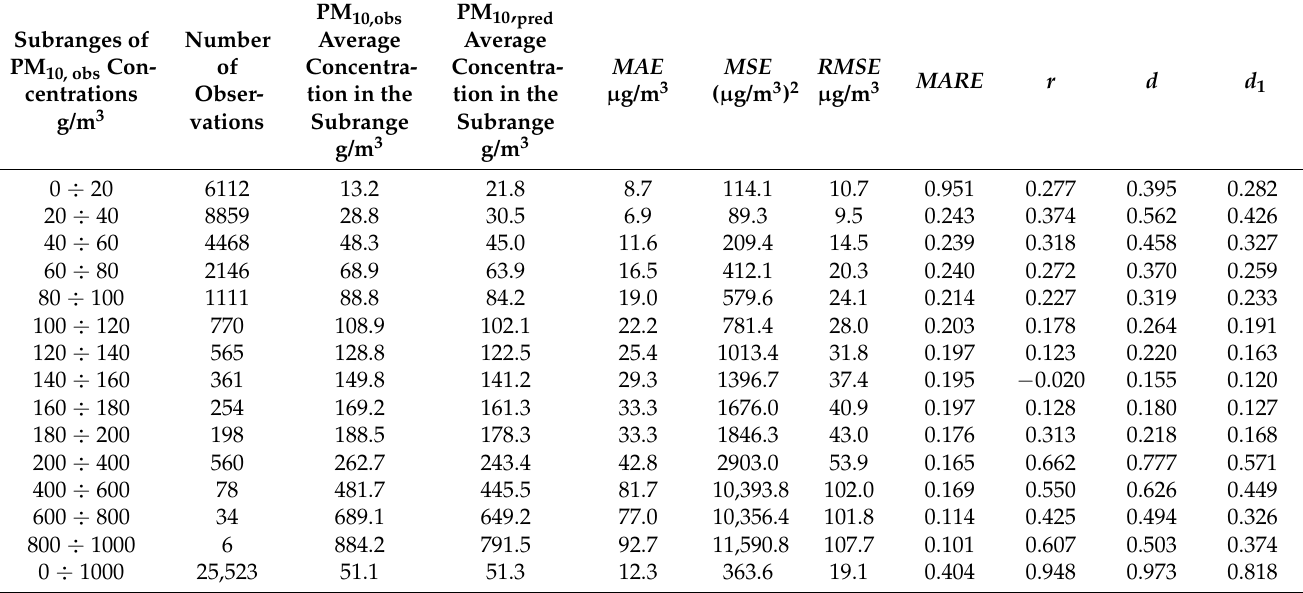
Table 6. Values of approximation errors calculated for different subranges and the entire range of PM 10,obs concentra- tions (hourly data, Zabrze 2011–2016), PM 10,obs means real PM 10 concentration, and PM 10,pred means predicted PM 10 concentration.